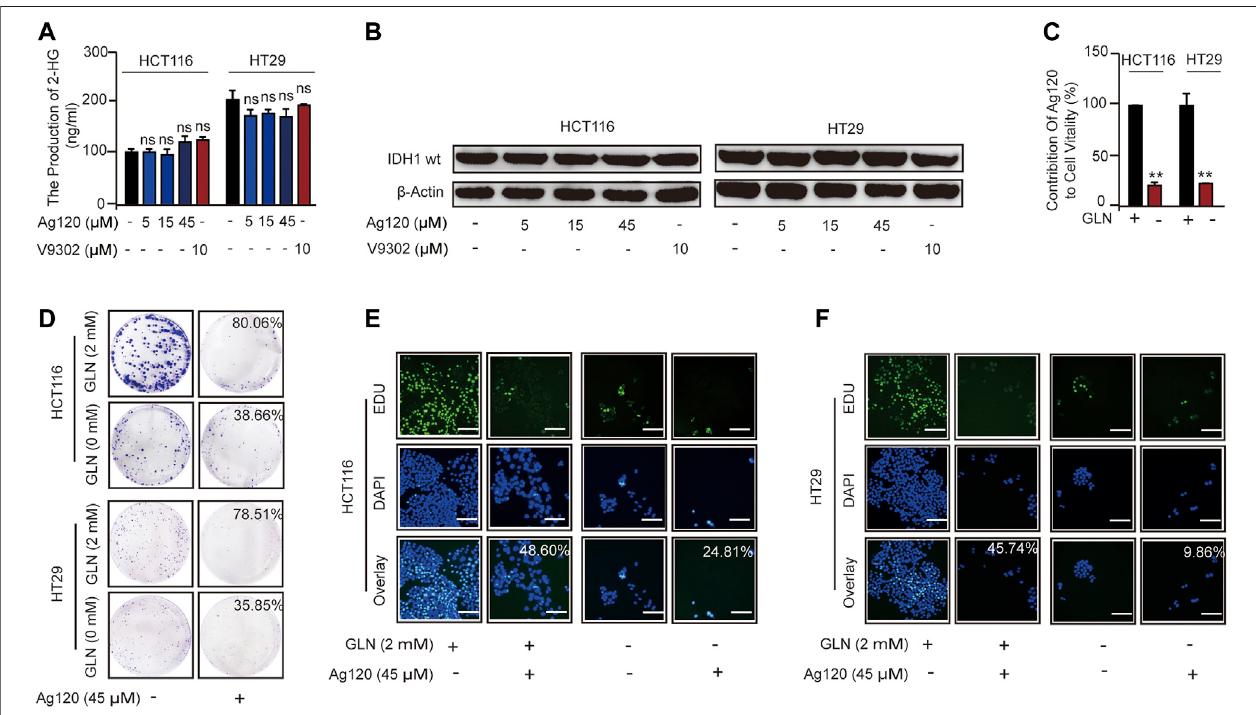
FIGURE 4 | Effects of Ag120 and glutamine depletion on CRC cells. (A,B) 2-HG production (A) and immunoblot analysis of IDH1mt expression (B) in CRC cells treated with Ag120 or V9302 for 72 h. (C) Quanti fi cation ofviable HCT116 and HT29 cells treated with vehicle or Ag120 (45 µM) for 72 h in DMEM medium containing2 or0 mM L -glutamine.CellnumbersweremeasuredusingaCCK-8kit.ContributionofAg120tocellviabilitywascalculatedbasedonthedatain SupplementaryFigure S3A . (D) Colony formation by CRC cells after 10 days of treatment with 0 or 45 µM Ag120 in 0 or 2 mM L -glutamine-containing medium. (E,F) Fluorescence microscopy images of EdU incorporation in HCT116 (E) and HT29 (F) cells treated for 72 h with 0or 45 µM ASCT2 in 0 or 2 mM L -glutamine-containing medium. Scale bars, 50 µm. Mean ± SD of three experiments. * p < 0.05, ** p < 0.01 by Student ’ s t -test.